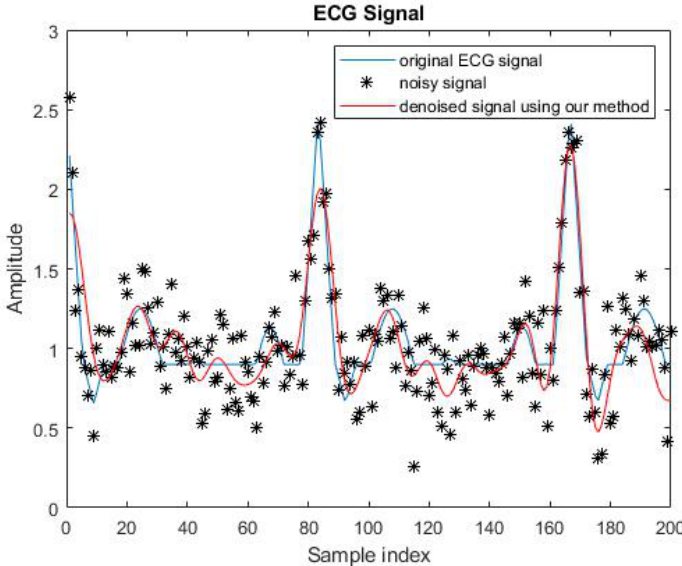
Figure 3. Application of our method to denoising a benchmark Electrocardiogram (ECG) type